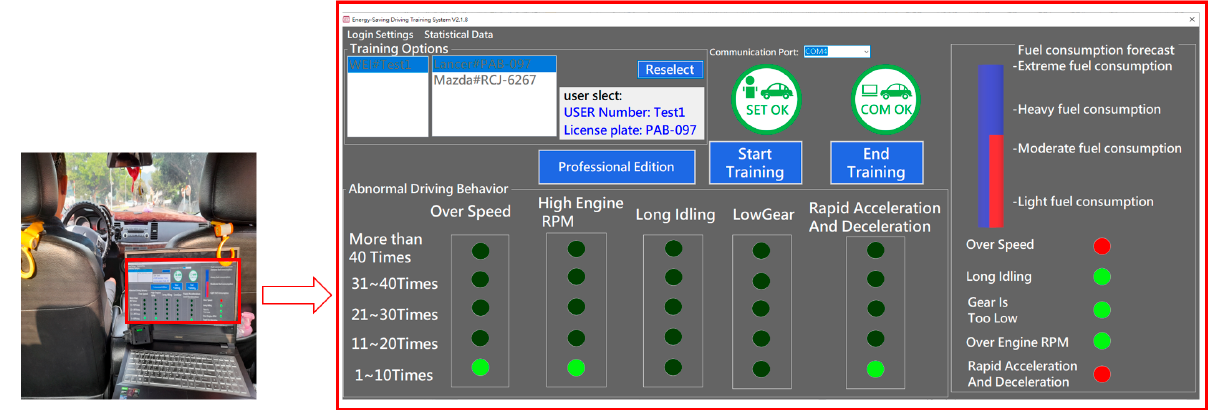
Figure 10. Real-time GUI display of the eco-driving assistant system during driving.